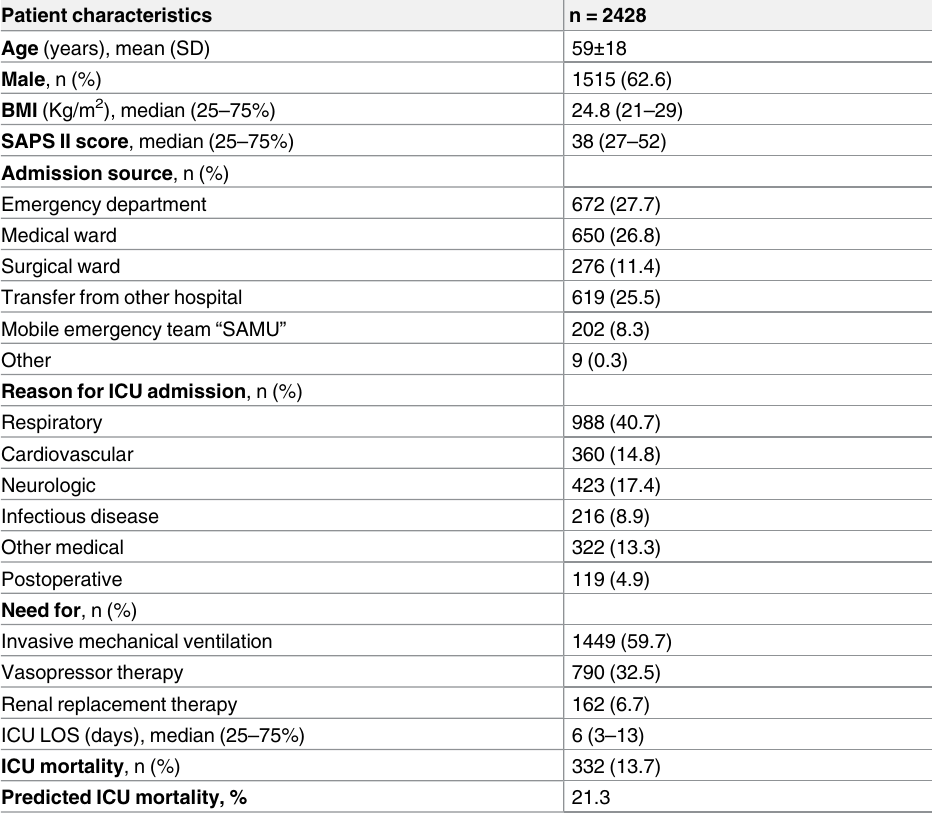
Table 1. Demographic and epidemiological characteristics of the studied population at the admission to the ICU; management, ICU length of stay and mortality. BMI: body mass index; SAPS II: simplified acute physiology score II; ICU: intensivecare unit; LOS: length of stay; “SAMU”: S ervice d’ A ide M e´dicale U